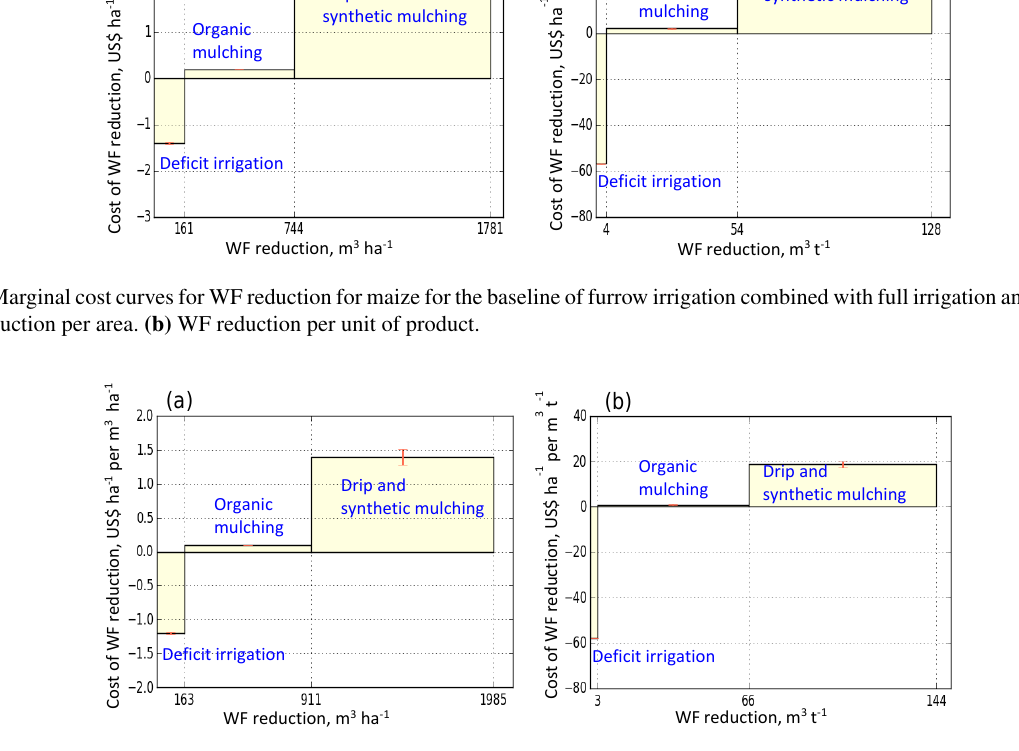
Figure 8. Marginal cost curve for WF reduction of maize for the baseline of sprinkler irrigation combined with full irrigation and no mulching. (a) WF reduction per area. (b) WF reduction per unit of